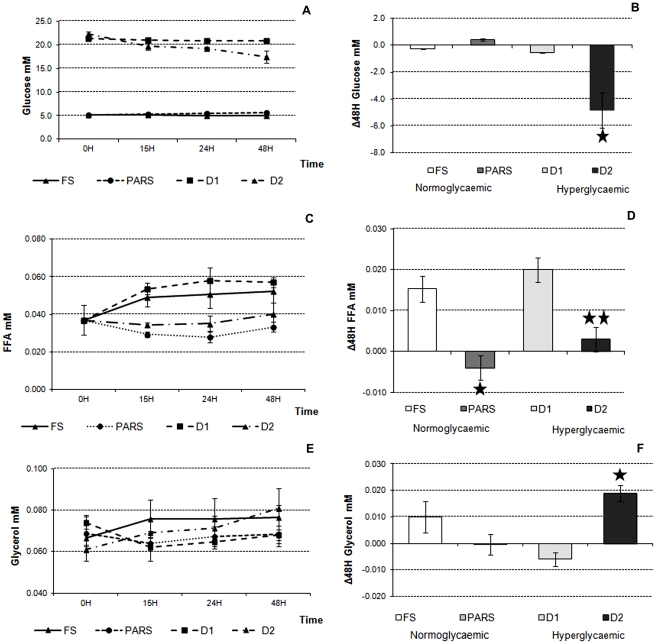
Glucose, FFA and glycerol in the 3-way cultures in FS, PARS, D1 and D2 conditions.A) Glucose variations over time. B) Changes in medium glucose concentration with respect to initial media concentration at 48 H (* = p<0.05 vs. D1). C) FFA variations over time. D) Changes in medium FFA concentration with respect to initial media concentration at 48 H (* = p<0.05 vs. FS; ** = p<0.05 vs. D1). E) Glycerol variations over time. F) Changes in medium glycerol concentration with respect to initial media concentration at 48 H (* = p<0.05 vs. D1). In all cases time 0 represents the levels of metabolites in fresh media. Data are expressed as means ± SD (3≤n≤6). Error bars represent the standard deviation.